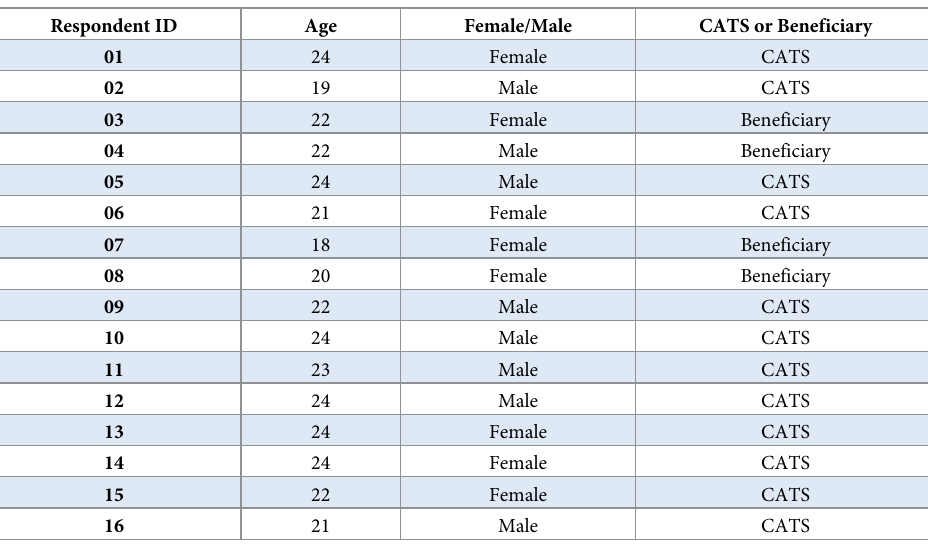
Table 1. Characteristics of respondents in relation to the Zvandiri program (N = 16). Respondent